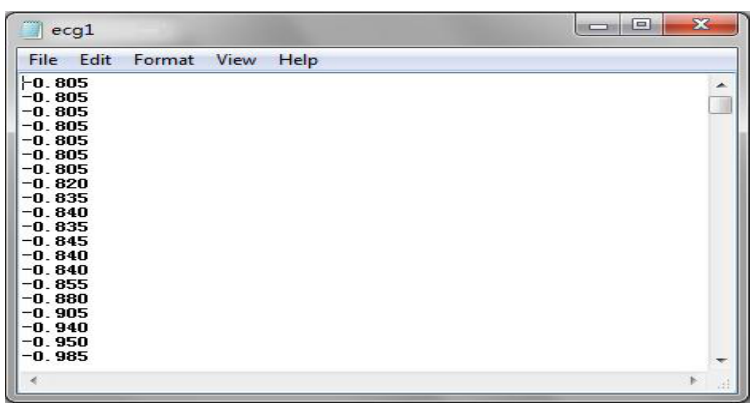
Figure 8. ECG data in text format.